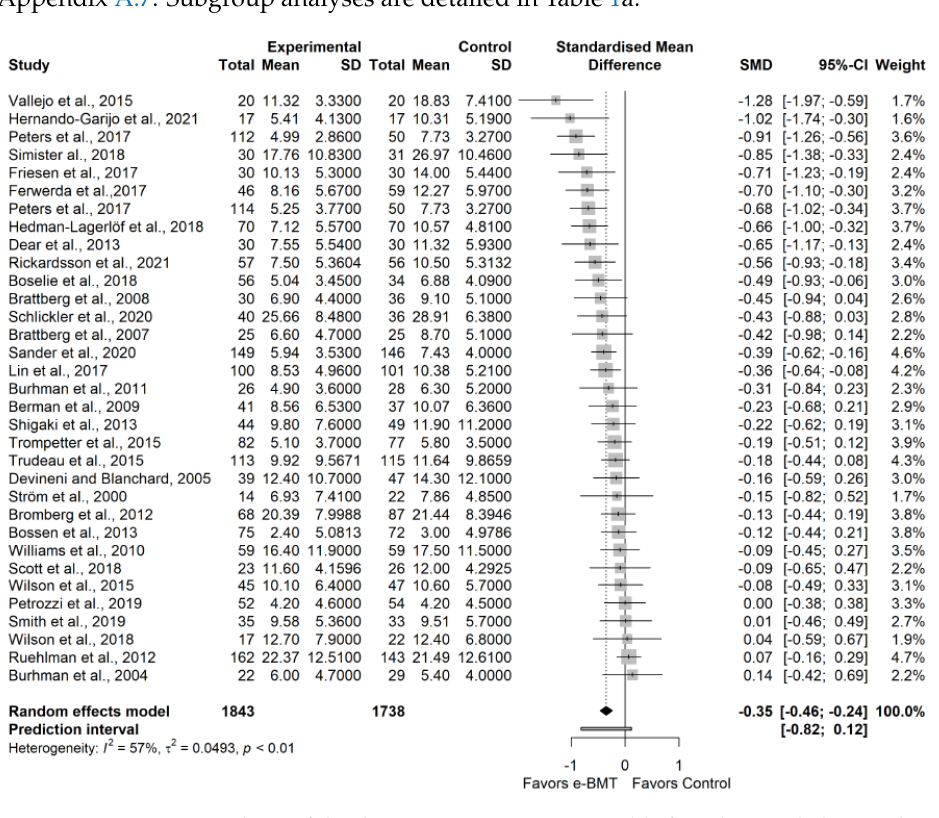
Figure 2. Sensitivity analysis of the depressive symptoms variable for telematic behavioral modifi- cation techniques against usual care or waiting list. Negative results favor the intervention group. The small boxes with the squares represent the point estimate of the effect size and sample size. The lines on either side of the box represent a 95% confidence interval (CI). e-BMT: Telematic Behavioral Modification Techniques.